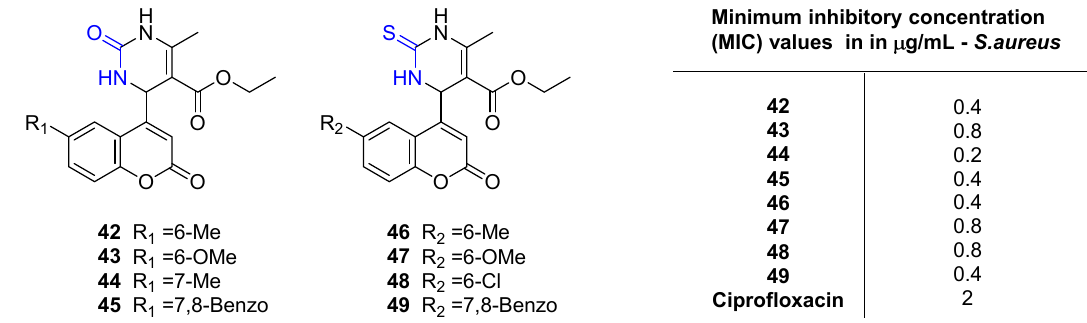
Figure 17. 3,4-dihydropyrimidinone-coumarin analogues and their MIC values against S. aureus .